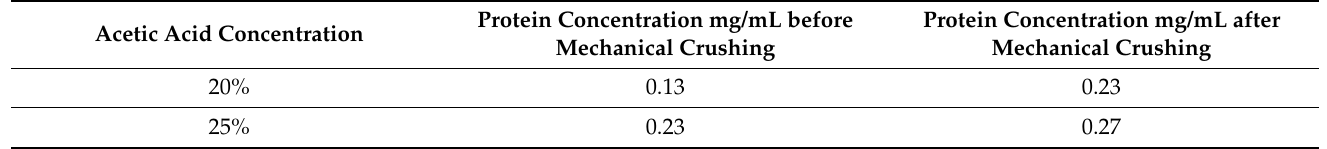
Table 1. Protein concentration after demineralizing the calculus with or without mechanical crushing. Measured by NanodropOne C at 205 nm with the 31-correction method.